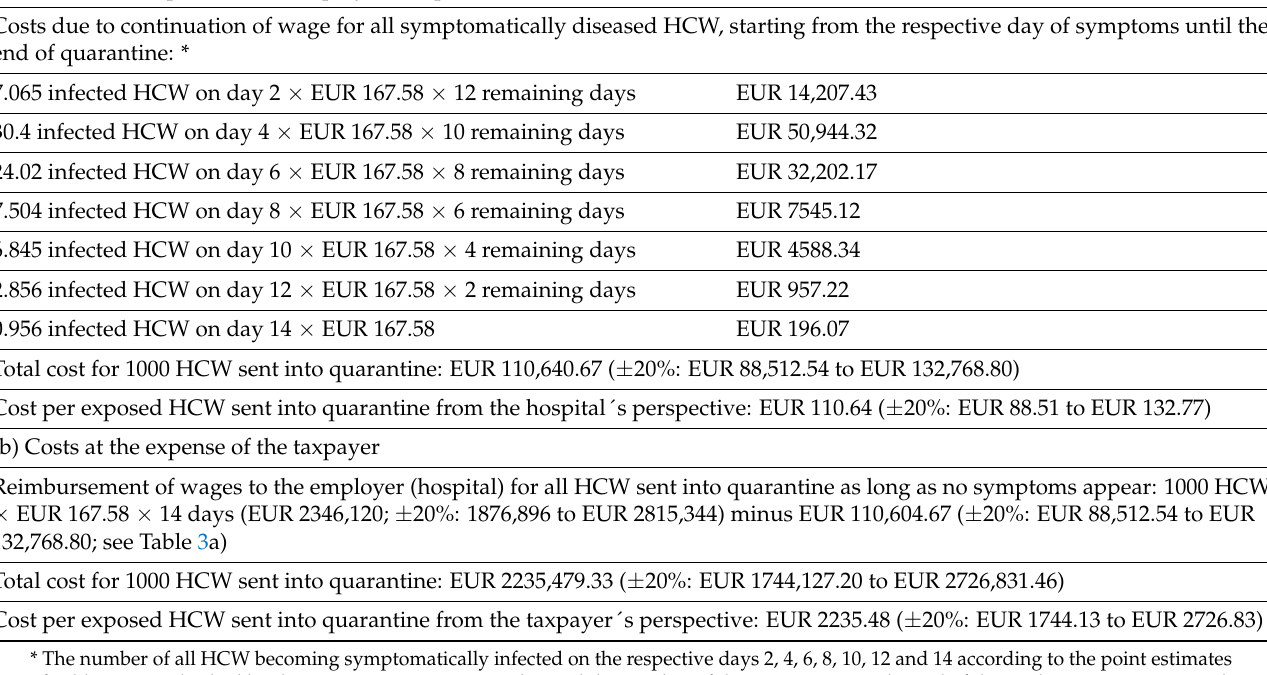
Legend to Table 1: Table 1 denotes the number of infected HCW in a hypothetical cohort of 1000 exposed HCW under quarantine on day 2, 4, 6, 8, 10, 12 and 14. d: day, TP: true positive, FN: False negative; S: symptomatic disease; NS: asymptomatic infection. Table 3. Costs of sending HCW into quarantine (per 1000 exposed